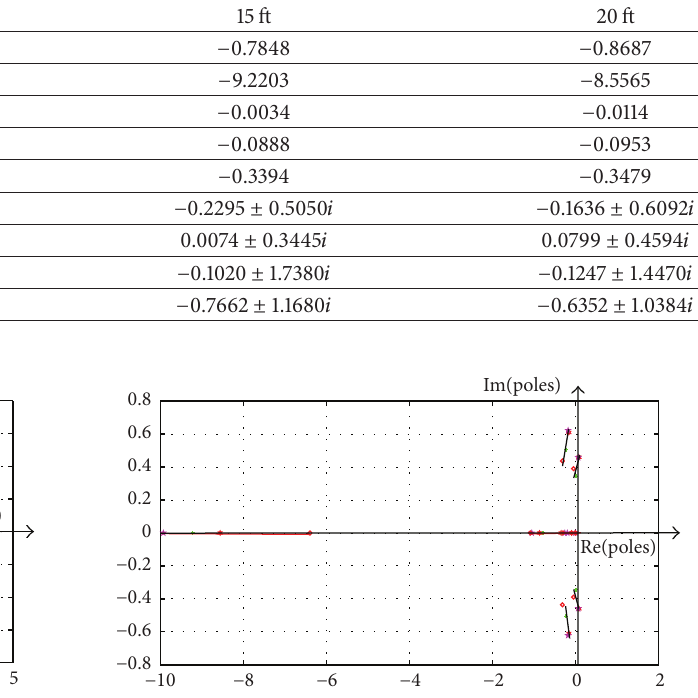
Figure 3: System root-locus diagram showing pole locus for constant slung length (15ft) as load weight is increased.